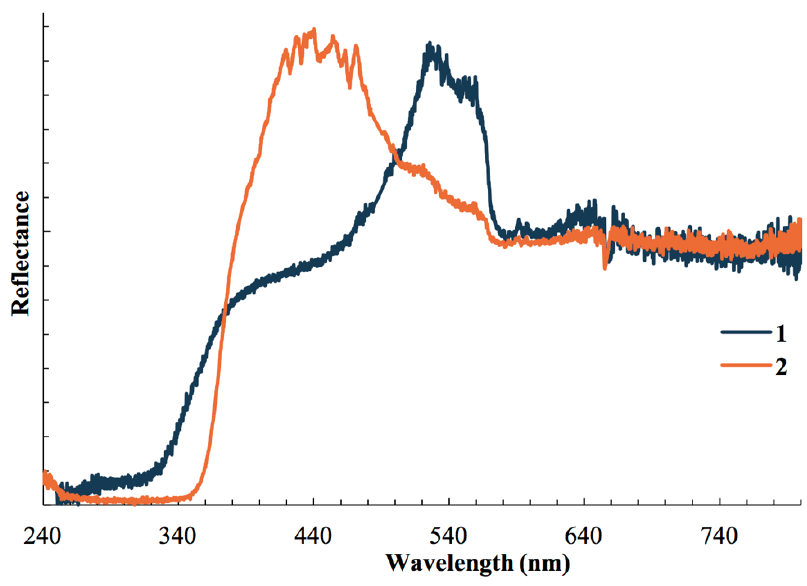
Figure 5. Di ff use reflectance spectra of solid samples of 1 and 2 at 298 K. Figure 5. Diffuse reflectance spectra of solid samples of 1 and 2 at 298 K.